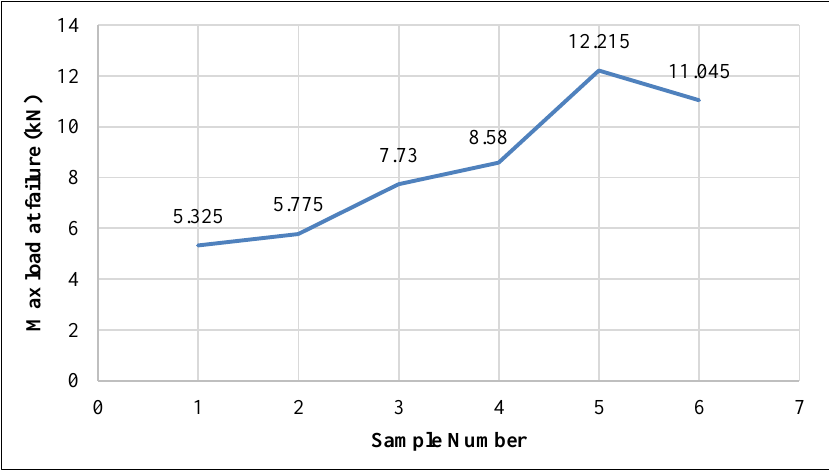
Figure 26. Maximum failure load for six